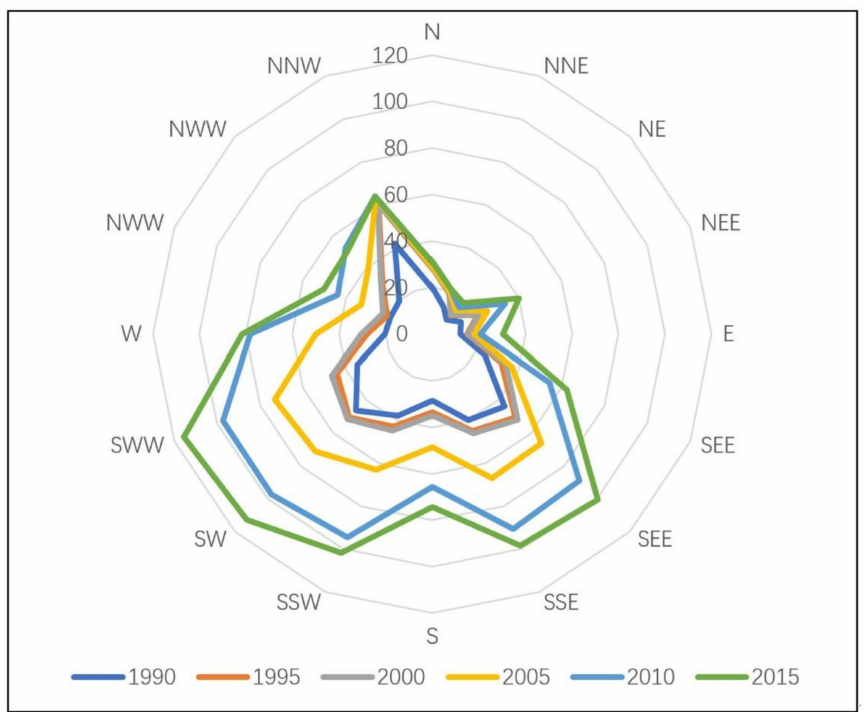
Figure 4. Statistical chart of the spatial changes in the rural residential distribution by azimuth in the suburbs of